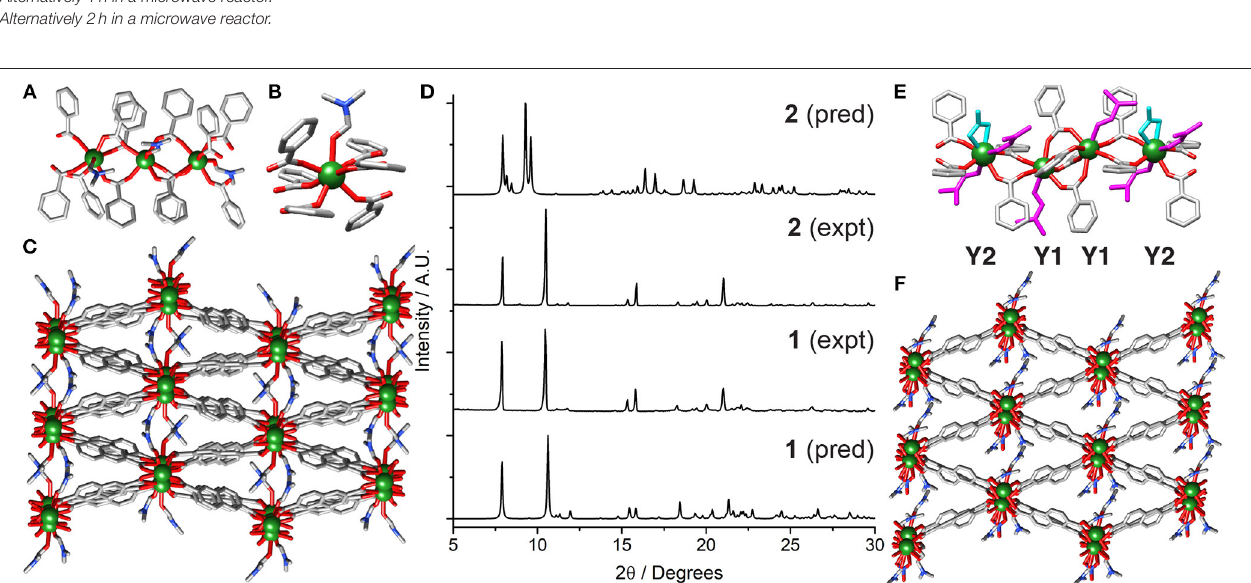
FIGURE 2 | Crystal structure of 1 . (A) The one-dimensional chain SBU. (B) The coordination sphere of Y1. (C) The overall packing structure showing potential porosity. (D) Stacked PXRD patterns of bulk samples of 1 and 2 compared to their predicted patterns, confirming crystals of 2 were isolated from material with bulk composition of 1 . Crystal structure of 2 . (E) One-dimensional chain SBU with coordinating nitrate (cyan) and DMF (magenta). (F) Packing structure showing structural relationship with 1 . H atoms and disorder removed for clarity in all crystal structure